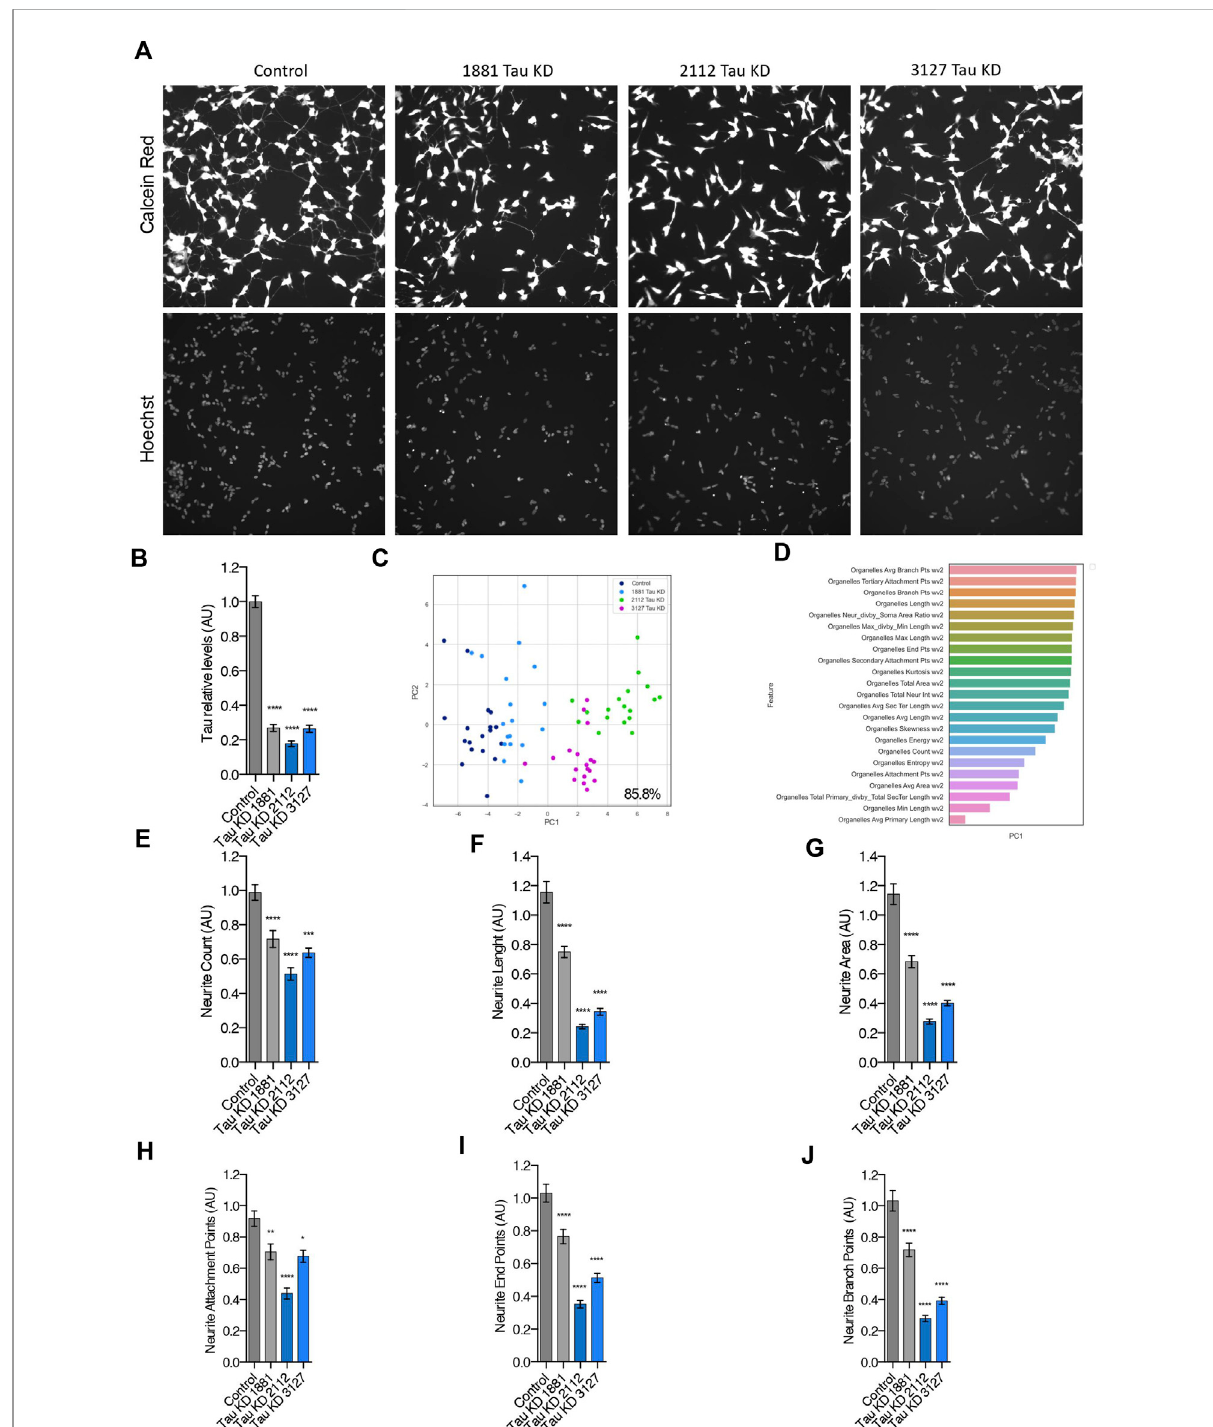
FIGURE 3 DepletionofTaucausesabnormalneuritemorphologyindifferentiatedSHSY5Ycells,similarlyasinElp1depletion . (A) Representativeimagesof Live fl uorescence microscopy staining of differentiated SHSY5Y cells control versus Tau KD lines (Tau KD 1881; Tau KD 2112, Tau KD 3127) using CalceinAM(Red)andHoechst(Blue)tovisualizeneuritemorphology.Scalebaris50 µm. (B) Immunolabelingandquanti fi cationofTaulevels (C) Two dimension principal component analysis (PCA) plot of stained cells based on morphological features. Symbols represent the control cells (dark blue); Tau KD 1881 cells (light blue), Tau KD 2112 (pink), Tau KD 3127 (green). each circle represent data extracted from 20 fi elds coming from one well,each fi eldcontainhundredsofcells.PCAScore85.8% (D) PlotoffeaturescontributiontotheseparationinthePCAanalysis (E – J) Quanti fi cation